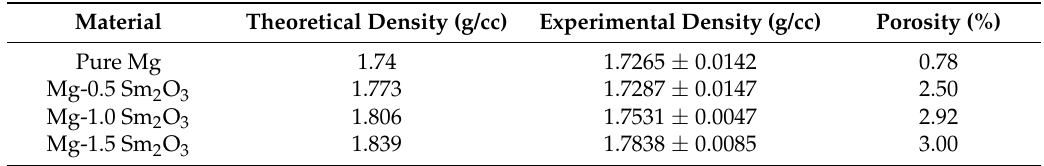
Table 2. Density measurements of pure magnesium and Mg-Sm 2 O 3